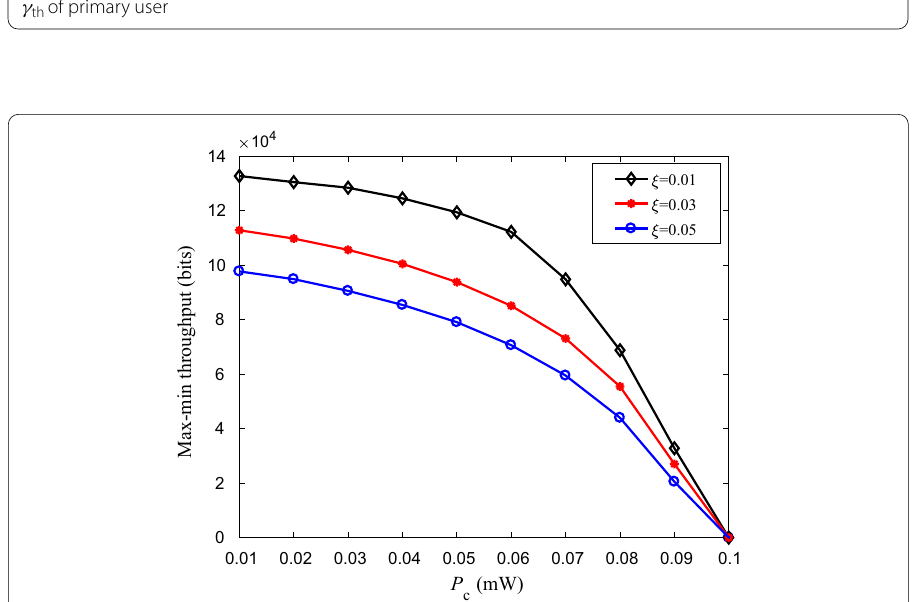
Fig. 5 Max–min throughput (bits) versus the minimum power consumption with different interference residual factor ξ for P max = 5